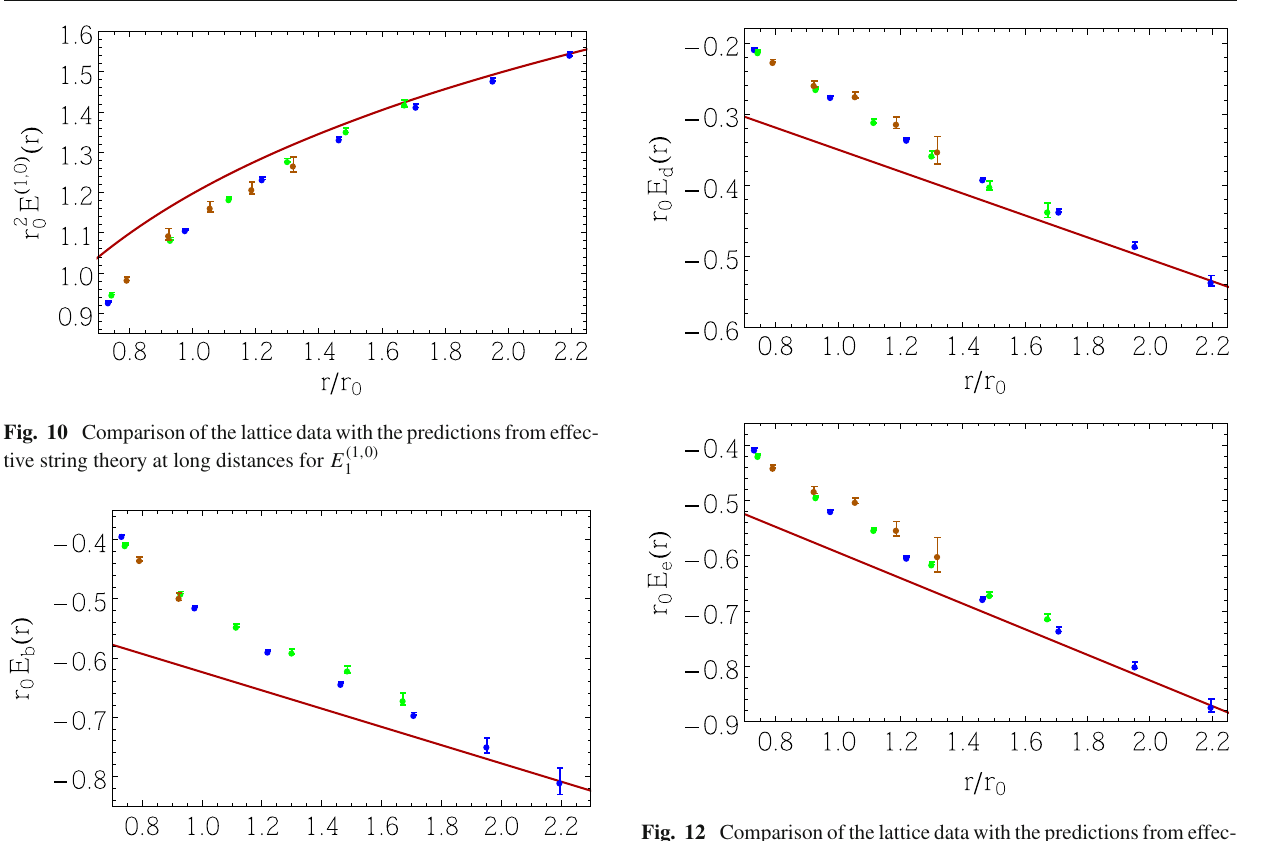
Fig. 12 Comparison of the lattice data with the predictions from effec- tive string theory at long distances for E d and E